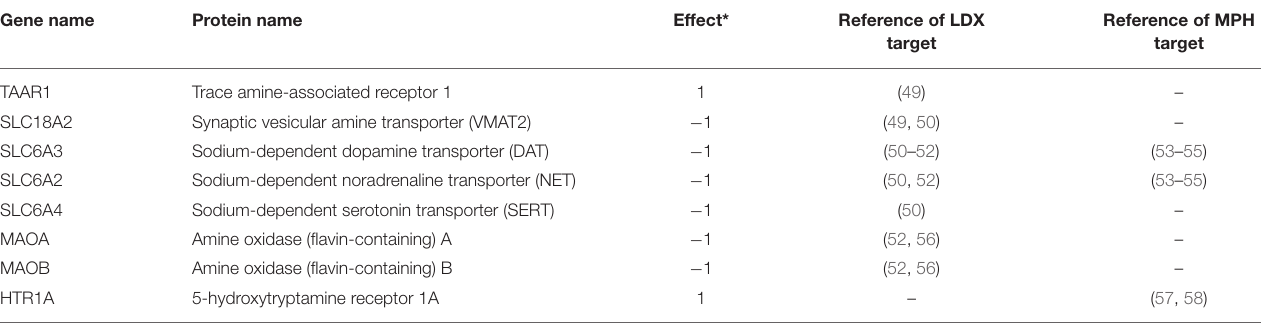
TABLE 1 | Identified protein targets for lisdexamfetamine and methylphenidate.